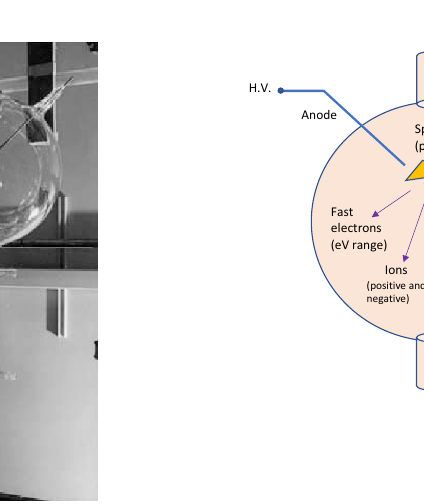
Figure 1. On the left, the Miller-Urey experimental apparatus. The lower flask contains the primordial ocean model, while, through the gas inlet/outlet on the right, the rest of the apparatus is filled with the strongly reducing primordial atmosphere, based on the knowledges of Miller’s times. The third neck of the lower flask is used to sample the liquid for analysis. The higher balloon displays the spark gap. Photo adapted from [25]. On the right, a schematic sketch of the upper glass flask. A* symbolizes the excited